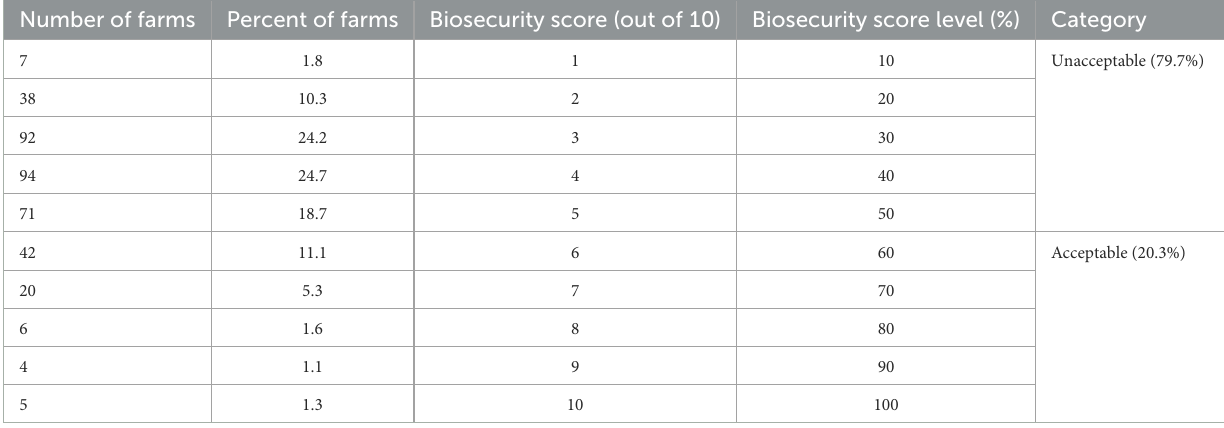
TABLE 5 Biosecurity security score level (%) of the dairy farms in central Ethiopia. Number of